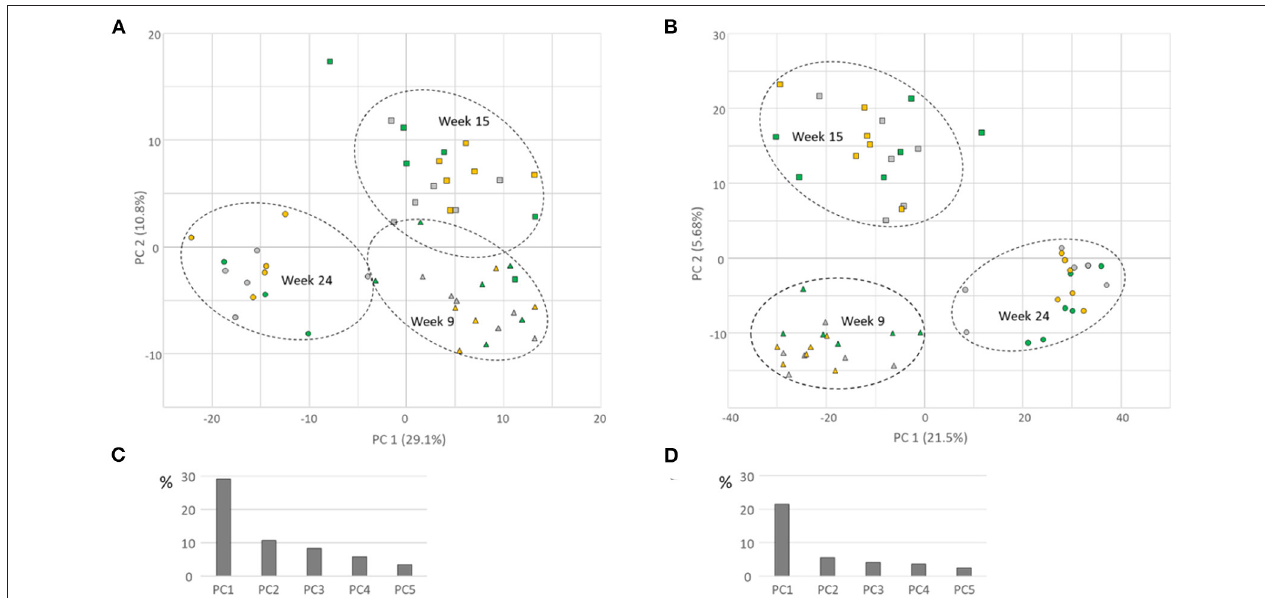
FIGURE 9 | Leaf metabolomes of strawberry plants in week 9 (triangles), 15 (squares), and 24 (circles). Principal Component Analysis (PCA) of mass signals obtained in positive ionization mode (A) and negative ionization mode (B) . Bar diagrams show the variance that can be explained by the first five components (PCs) for positive (C) and negative (D) ionization mode. Gray symbols: mock-treated control plants; green symbols: MeJA-treated every 3 weeks; yellow symbols: MeJA treatment upon scouting.